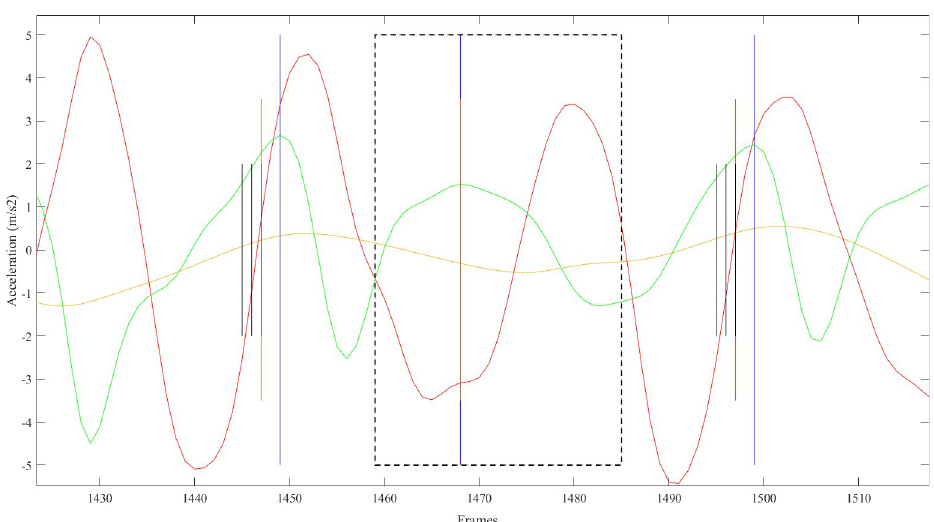
Fig 2. Example frame demonstrating a missed step identified within the locking period. A missed step (vertical blue line, frame 1468) identified within adjusted search range (black dotted line). A foot strike was inserted (vertical orange line, frame 1468) at timestamp corresponding to the peak AP acceleration (green curve) in this period.